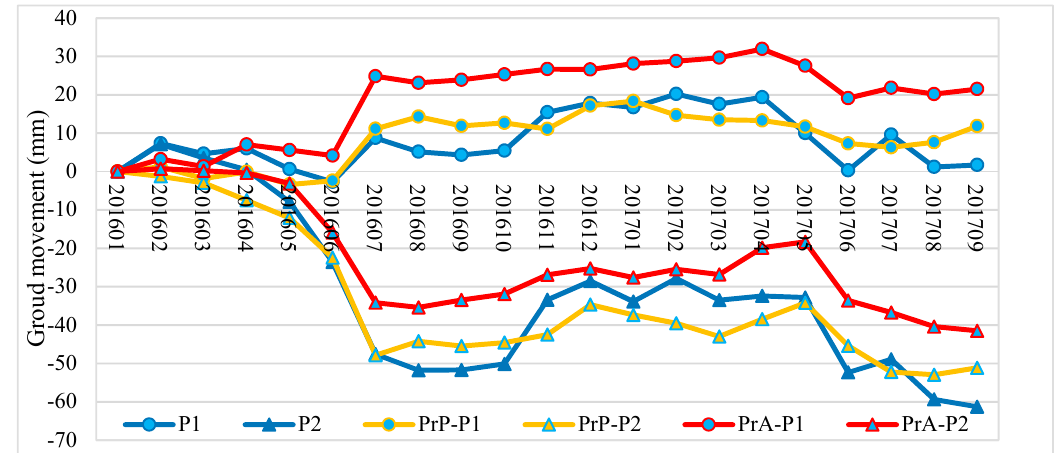
Figure 6. The absolute displacement differences between the landslide and the surrounding area with respect to the reference locations (PrP and PrA). The representative points P1 and P2 at different times for PrP or PrA are plotted as curves: PrP-P1 or PrA-P1 and PrP-P2 or PrA-P2, respectively.